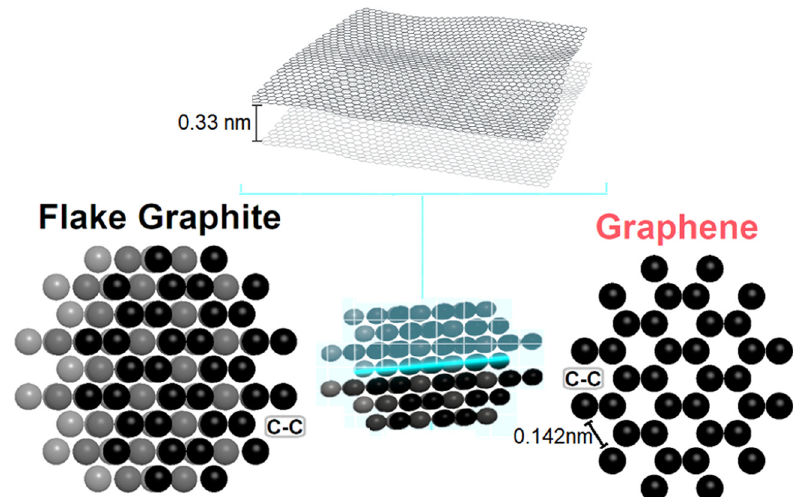
Figure 1: 3D - schematic design of graphene and fl ake graphite.